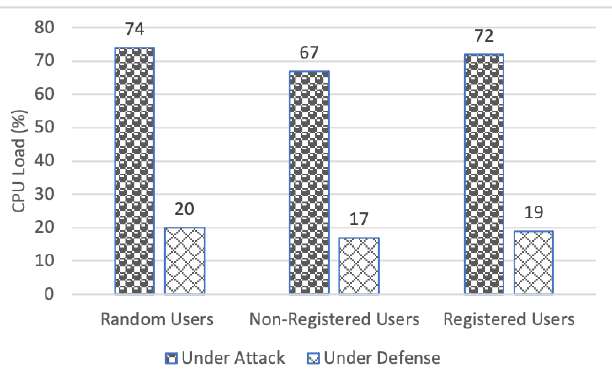
Figure 9. Average SIP server CPU loads for registered, nonregistered, and random users after the SIP-DRDoS attack and after the